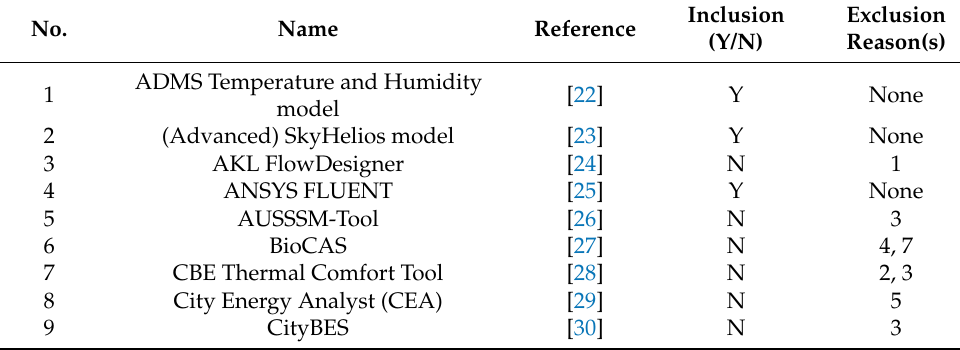
Table 1. Flow chart of the methods used to identify, assess the eligibility of models and their inclu-sion/exclusion from full review.